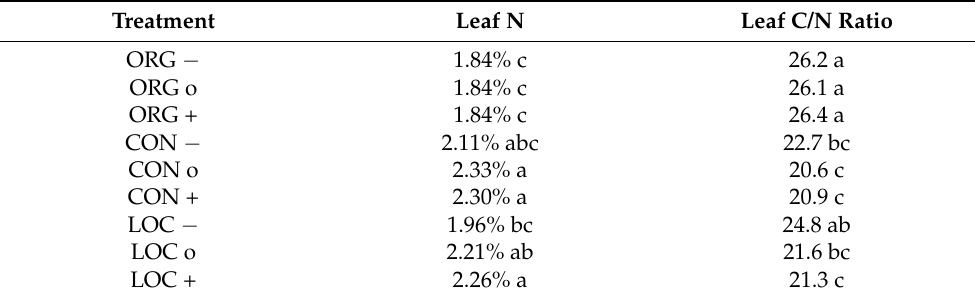
Table 3. Mean values for leaf nitrogen (N), and carbon/nitrogen (C/N) ratio among strawberries grown under nine different management regimes. ORG = organic inputs, CON = conventional inputs, LOC = low carbon inputs; ( − ) = low nitrogen fertilizer, (o) = recommended rate of N fertilizer, (+) = recommended rate of N fertilizer plus supplemental inputs. Treatment